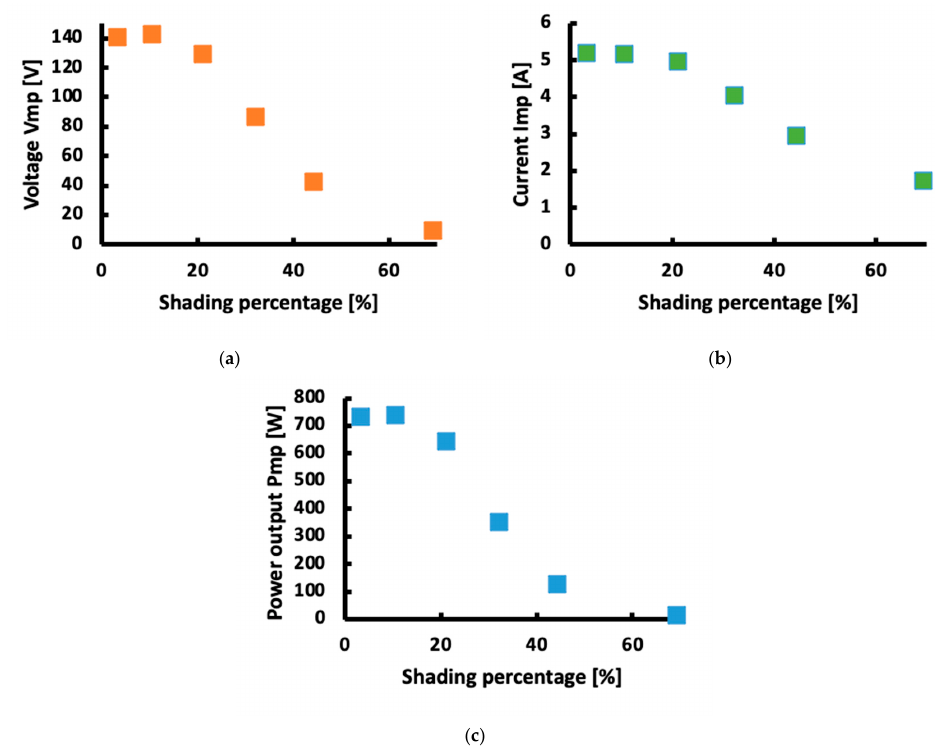
Figure 7. The effect of shading percentage on the first PV cells connected with bypass diode of the PV modules in array A: ( a ) voltage and shading percentage, ( b ) current and shading percentage, and ( c ) power output and shading percentage.